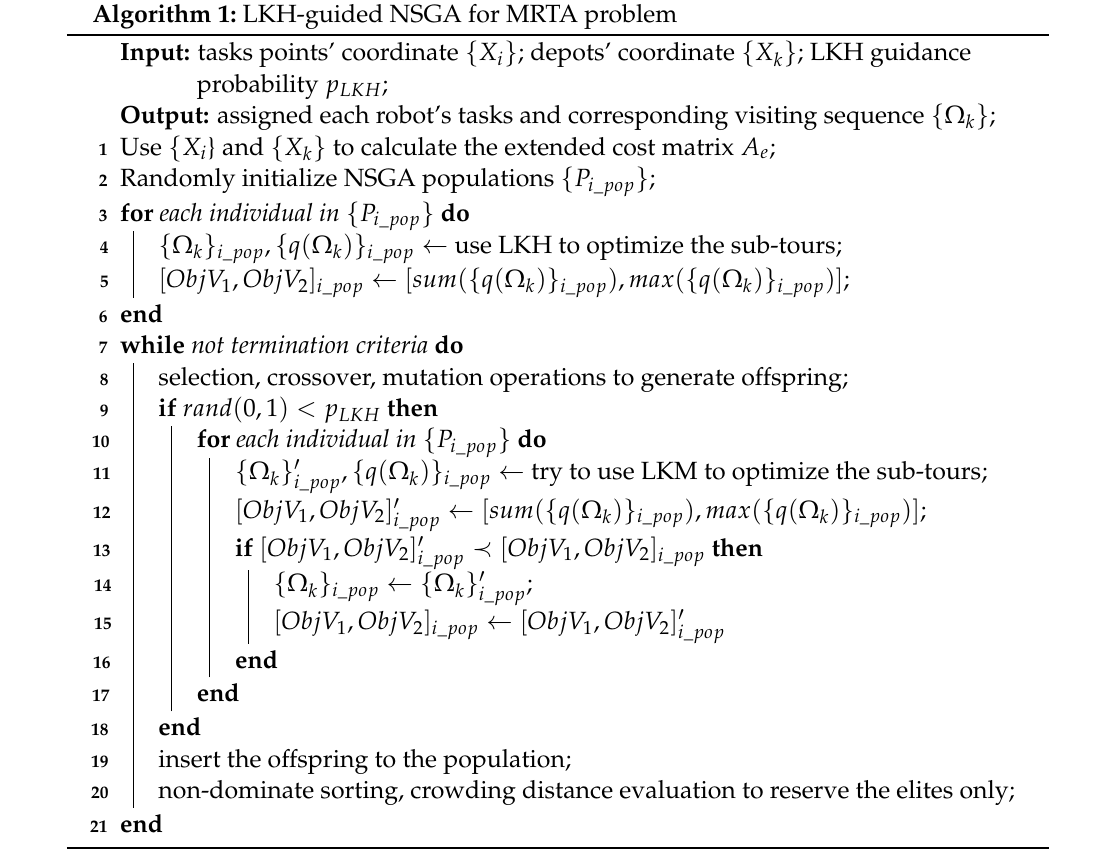
Algorithm 1: LKH-guided NSGA for MRTA